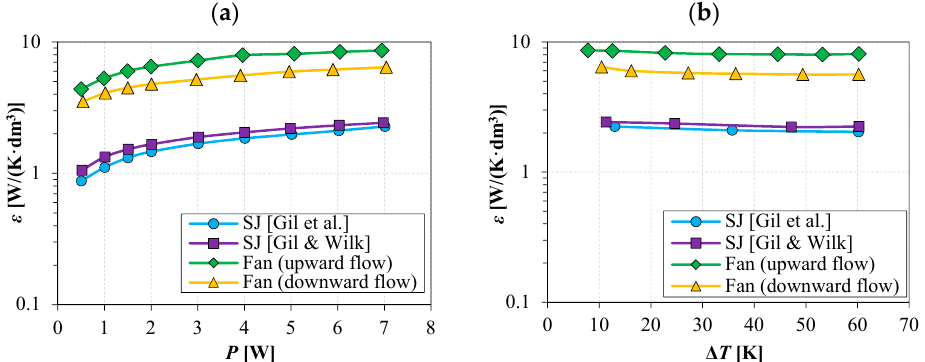
Figure 10. The heat transfer rate of the heat sink per unit temperature difference and unit volume of the cooling device ε as a function of ( a ) the power supplied to the cooling device; ( b ) temperature difference ∆ T = ( T b − T ∞ ) at the power of P = 7.0 W. Data from: Gil et al. [27], Gil and Wilk [ Error! Reference source not found. ].